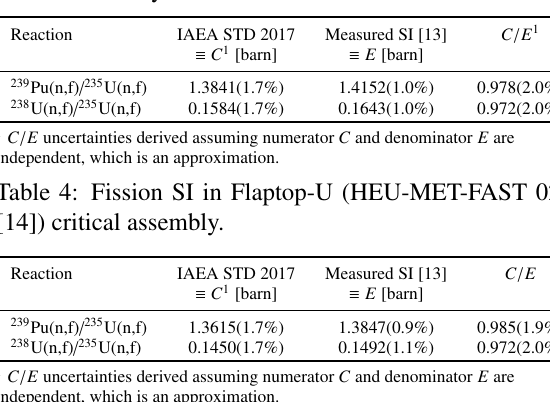
Table 3: Fission SI in Godiva (HEU-MET-FAST 001 [14]) critical assembly.